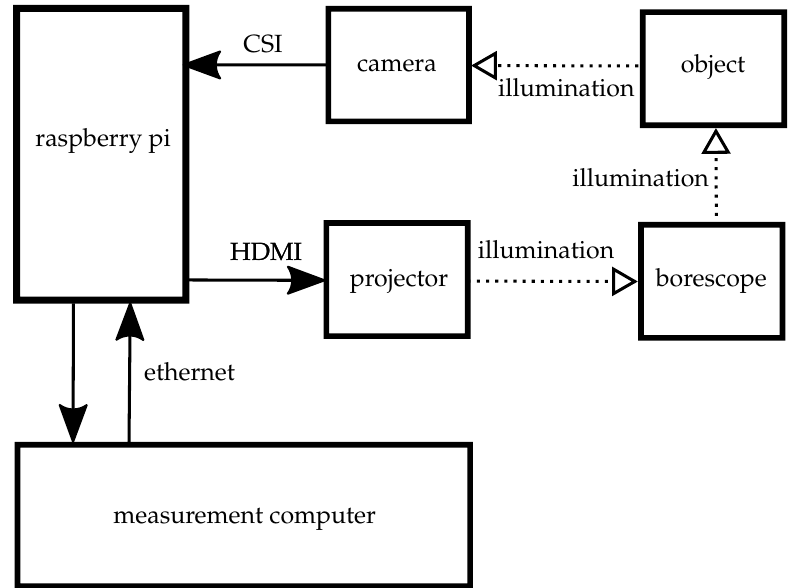
Figure 1. Signal plan for the measurement